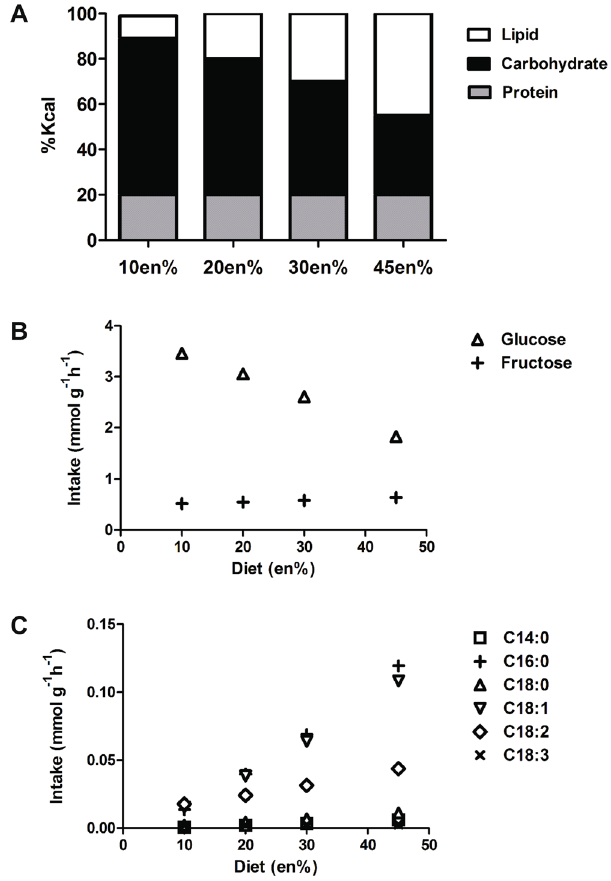
Figure 2. Diet description and intake. ( A ) Overall dietary composition expressed as %kcal; ( B ) Maximal potential intake rates of glucose and fructose, the two hexoses present in the diet; ( C ) Maximal potential intake rates of the different fatty acid species present in the